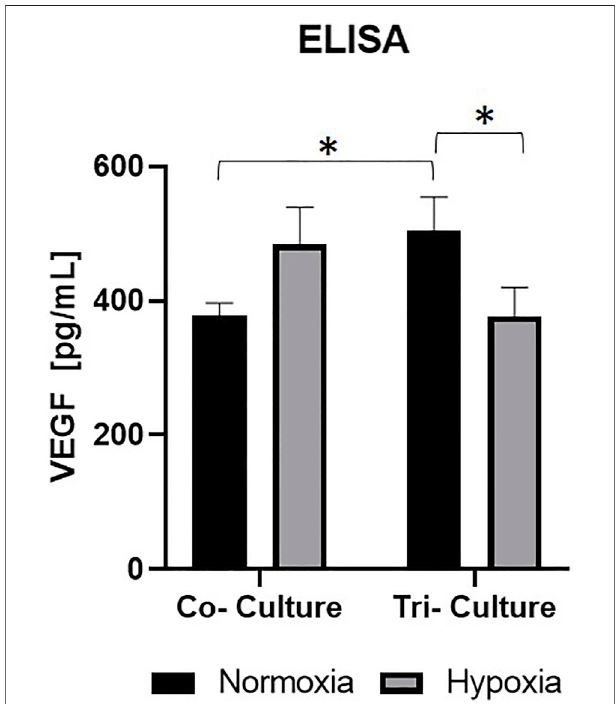
FIGURE 4 | ELISA of co-and tri cultures under different culture conditions with the pro-angiogenic cytokine VEGF. VEGF concentration in cell-free medium was subtracted from all measured values. Error bars show standard deviation. Statistical signi fi cance indicated by * shows signi fi cance ( p < 0.05) between mean values.